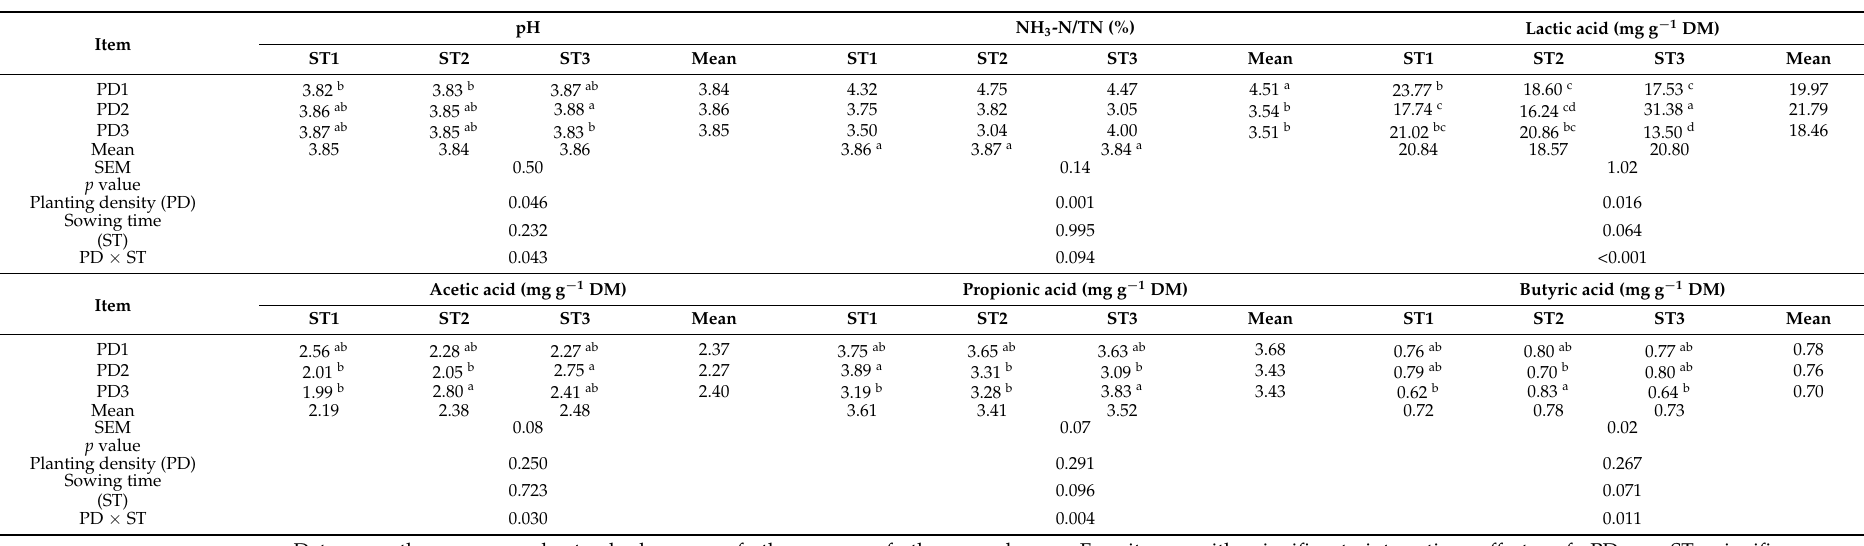
Table 6. Effects of sowing time and planting density of soybean on fermentation profile of samples after 60 days of silage in corn-soybean strip intercropping